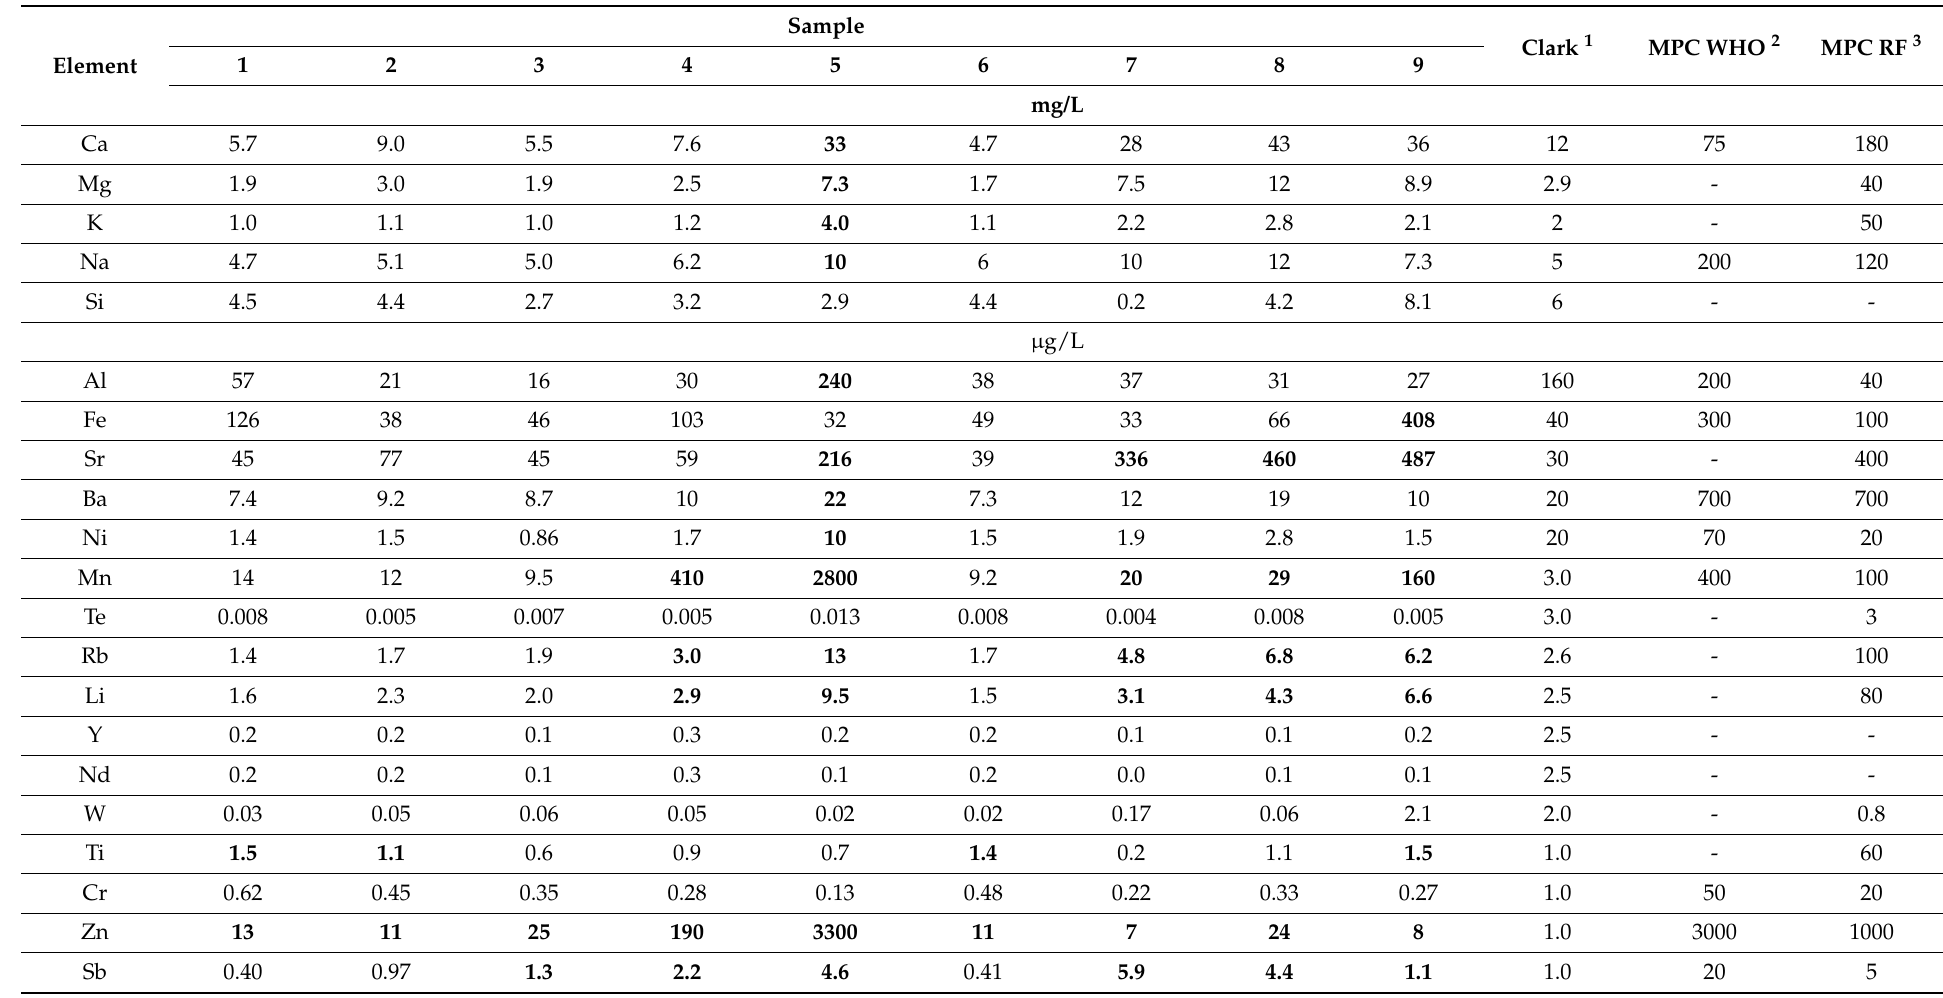
Table 3. Microelement composition of the surface waters in the surrounding area of the Shahtama tailings (samples 1–9): a stream entering the surface of the tailings dump from the decay (1); ponds on the surface of the tailings (2–5); natural stream flowing near the tailing dumps at a point lower in the relief (6); storage